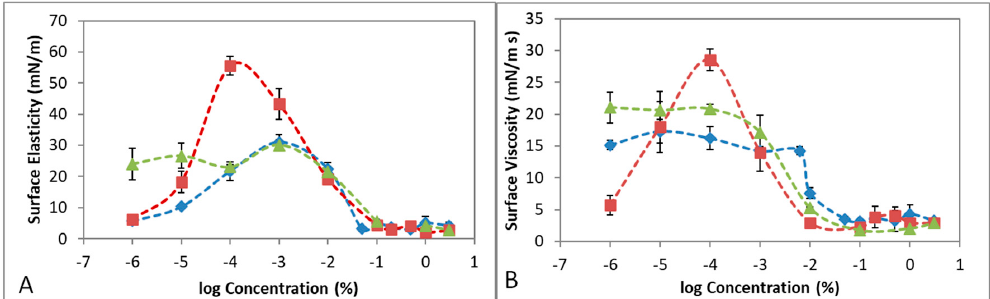
Figure 5. ( A ) Surface dilatational elasticity (1 Hz). ( B ) Surface dilatational viscosity (0.01Hz) attained after 1 h of adsorption at constant surface area, 0,9% NaCl and T = 20 °C as a function of bulk concentration of POL. POL (blue rhombus), POL + 0.3% HA (red squares), and POL + 0.1 mM F68 (green triangles). Values plotted are mean values of three independent measurements, and standard deviations are plotted as error bars. Lines are a guide for the eye.